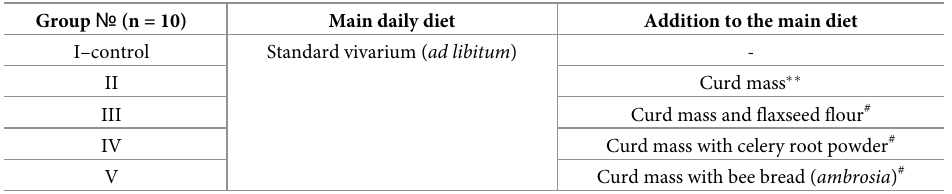
Table 1. Group name and diet content of Sprague-Dawley (SD) breed